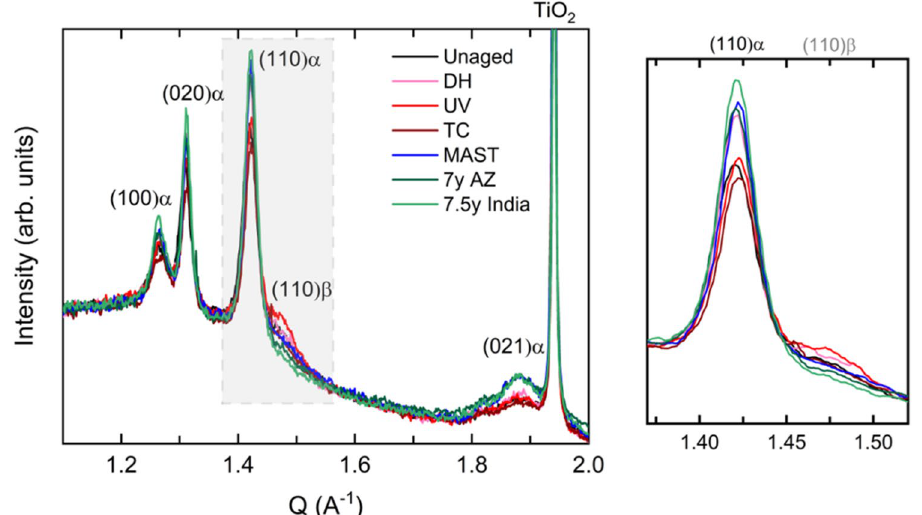
Figure 5. WAXS diffractograms identifying crystal planes corresponding to PVDF α- and β-phases and TiO 2 pigment in PVDF-B aged with different test conditions. The inset on the right shows the detail of the peaks corresponding to (110)α and (110)β crystal phases compared in Table